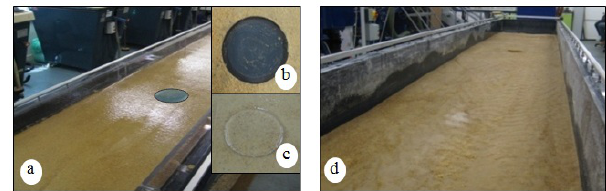
Figure 4: Sediment tank with frozen rough bed.